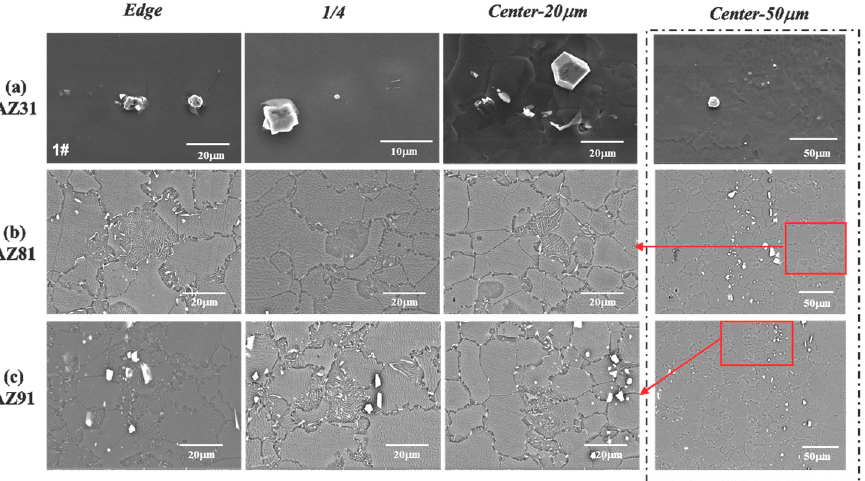
Figure 2. SEM pictures of three as-extruded Mg alloy sheets in different positions: ( a ) AZ31; ( b ) AZ81; ( c ) AZ91.